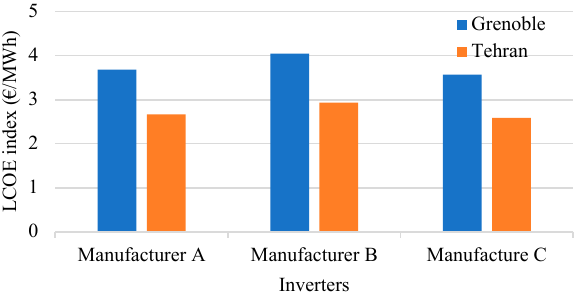
Figure 6. The LCOE index in each inverter for locations Grenoble and Tehran.